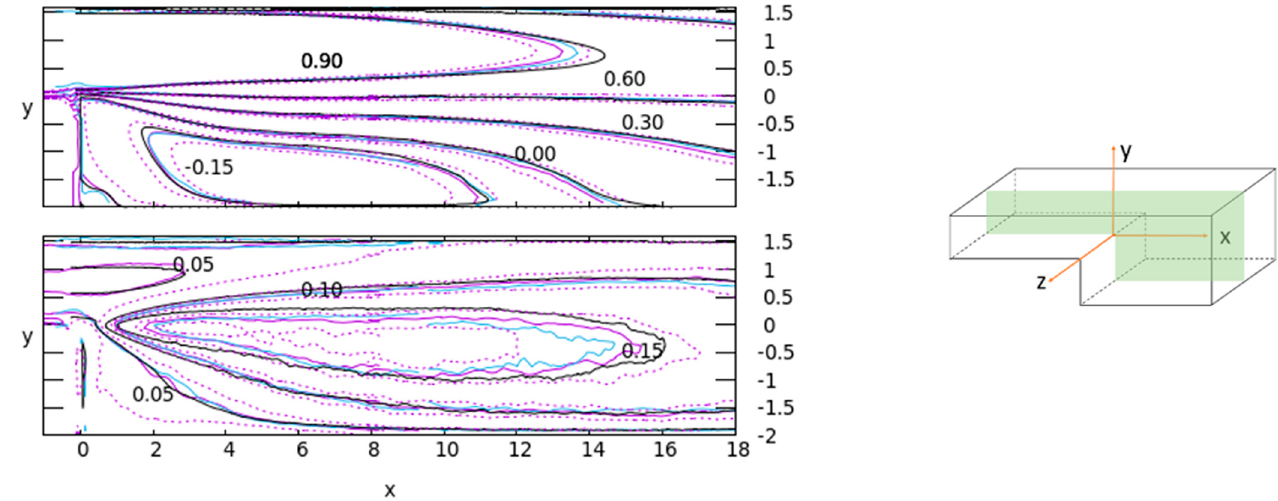
Figure 6. Streamwise velocity u contours (top) and v RMS (bottom) in plane z = 0. Solid contours: case ‘z − 0’—violet, case ‘z − 0a’—blue, DNS—black. Violet dotted contours: sensitivity contours of ‘z − 0’ case; ±0.03 and ±0.01 for u and v RMS , respec- tively.